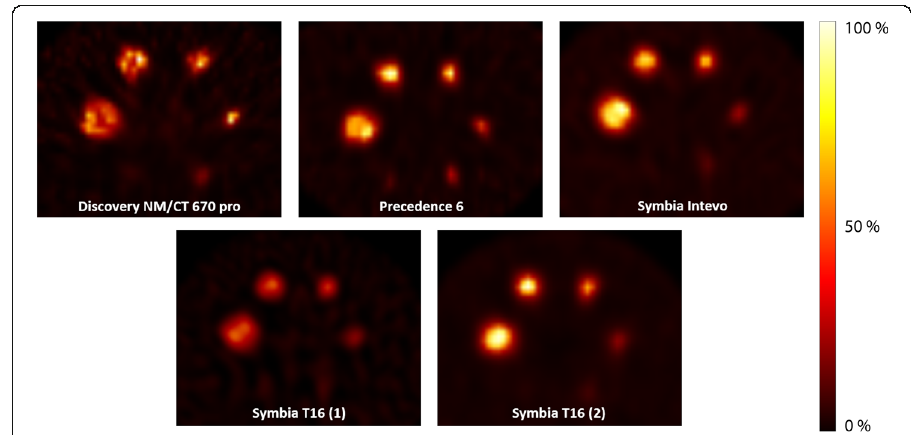
Fig. 2 Images of the NEMA IEC body phantom for all systems, reconstructed with a vendor-specific algorithm